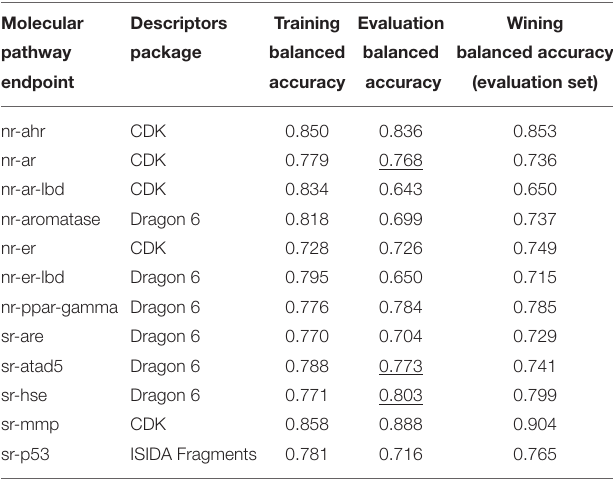
TABLE 3 | Performance of the single-descriptor-package models with the highest training set balanced accuracy for each pathway endpoint. Molecular